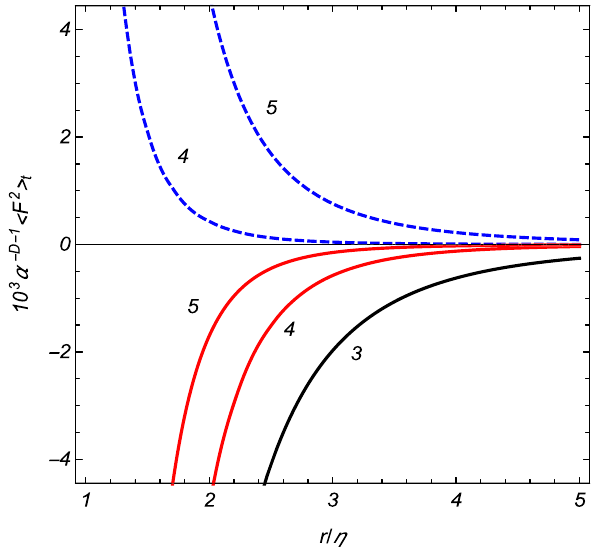
Fig. 1 Topological contributions in the VEVs of the squared electric and magnetic fields for q = 2 . 5 and for spatial dimensions D = 3 , 4 , 5 (the numbers near the curves). The full/dashed curves correspond to the electric/magnetic